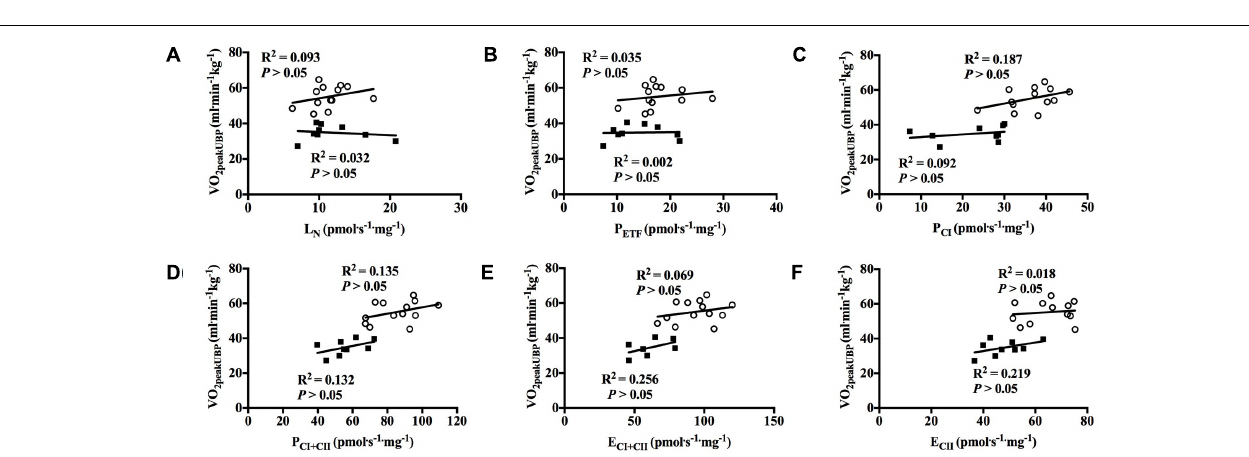
FIGURE 8 | Correlation between peak oxygen uptake (VO 2peak ) in upper body poling and respiratory flux for M. triceps brachii with both groups individually. (A) leak respiration in absence of adenylates (L N ), (B) fatty acid oxidative capacity (P ETF ), (C) complex I respiration (P CI ), (D) complex I and complex II respiration combined (P CI + CII ), (E) electron transfer system capacity (E CI + CII ), and (F) electron transfer system capacity of complex II alone (E CII ). (cid:4) = CON, (cid:13) = XC